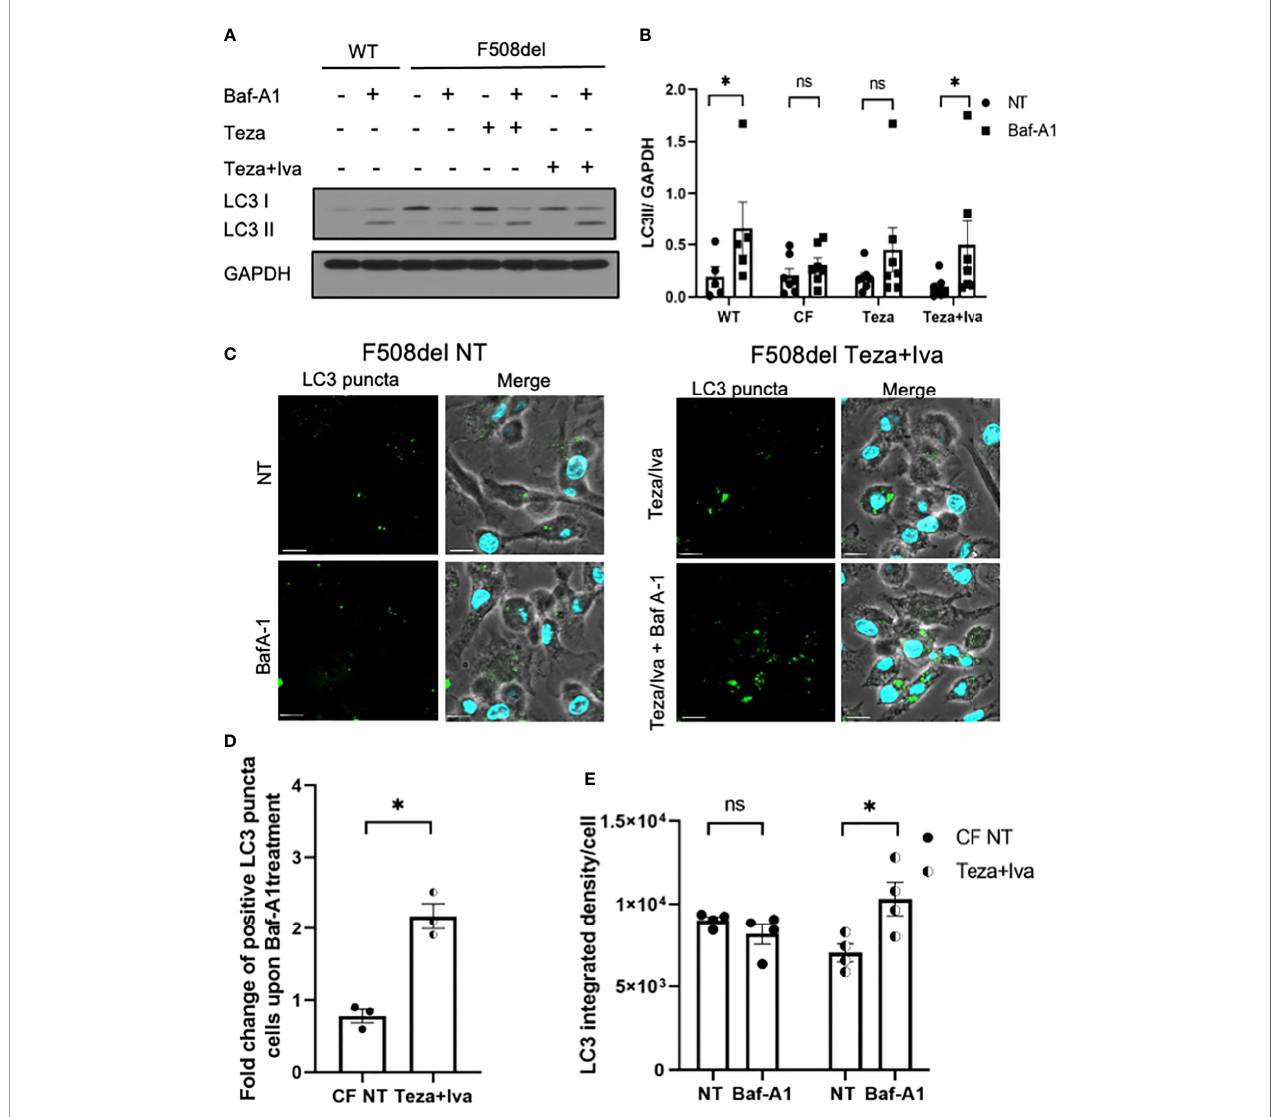
FIGURE 6 | CFTR modulators restore defective autophagy in F508del macrophages. (A) Representative LC3 immunoblot from wild-type (WT) and F508del macrophages treated with either vehicle (non-infected (NT)) or 10 µM of Teza − /+ 5 µM of Iva for 24 h, followed by − /+100 nM of Baf-A1 (n = 4 biological replicates). (B) Densitometry analysis for LC3II in WT and F508del macrophages shown (A) , representing the ratio of LC3II to GAPDH. Data represent mean ± SEM (n = 5 WT, n = 7 cystic fi brosis (CF)). Statistical analysis was performed using two-way ANOVA; *, p ≤ 0.05; **, p ≤ 0.01; ns, non-signi fi cant. (C) Confocal microscopy images showing LC3 puncta accumulation in F508del macrophages either NT or treated with Teza+Iva − /+ Baf-A1 (100 nM) (n = 3 biological replicates). Scale bar = 10 µm. (D) Percentage of cells expressing >5 LC3 puncta in F508del macrophages shown in panel (C) Data represent mean ± SEM calculated by scoring at least 200 cells from randomly chosen fi elds of view, normalized to the total number of cells from 3 independent experiments. Statistical analysis was performed using paired t-test; *, p ≤ 0.05. (E) LC3 integrated density in F508del macrophages either NT or Teza+Iva treated − /+ Baf-A1. Data represent mean ± SEM calculated using ImageJ software from at least 5 randomly chosen fi elds of view with approximately 200 cells from 5 independent experiments. Statistical analysis was performed using one- way ANOVA; *, p ≤ 0.05; ns, non-signi fi cant